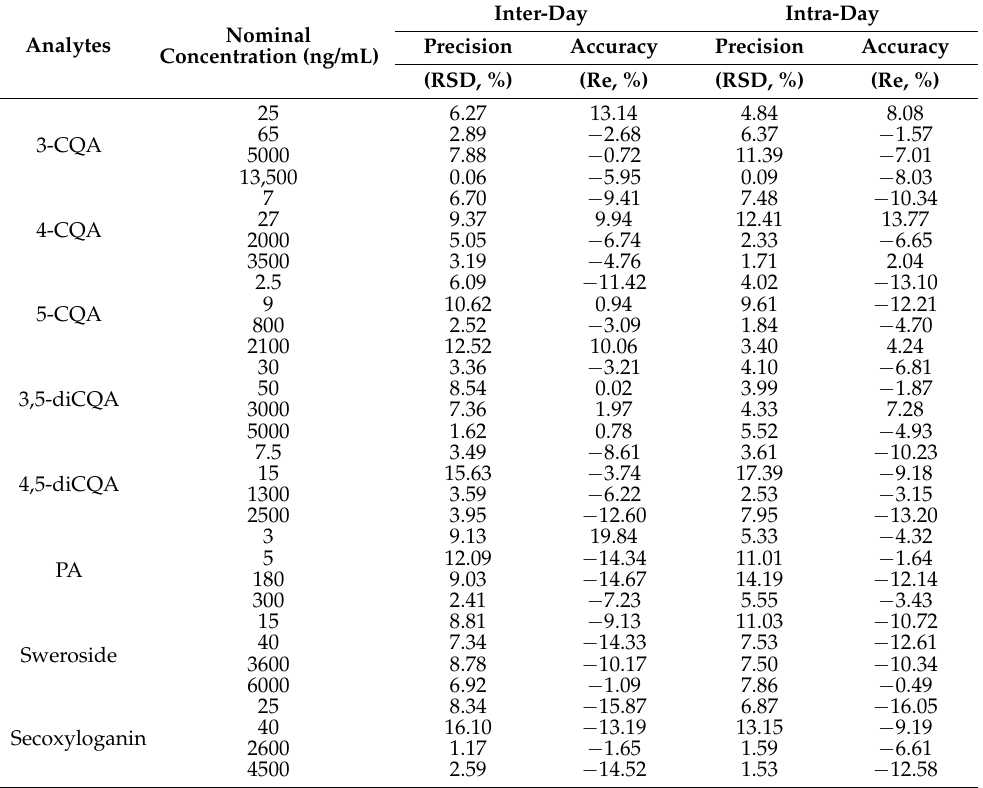
Table 3. Intra- and inter-day precisions and accuracies for the determination of the eight compounds from the assay samples (mean ± SD, n =